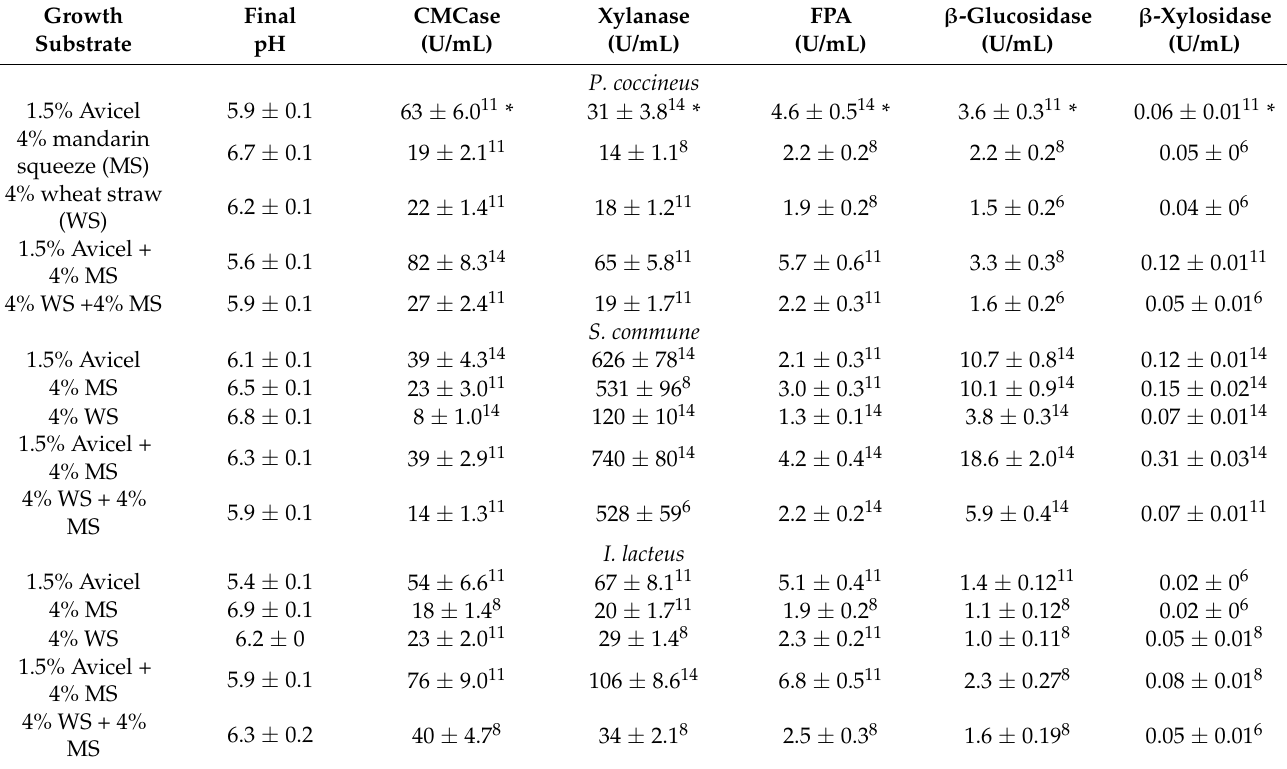
Table 1. Modulation of basidiomycetes hydrolytic enzyme activity by chemically different growth substrates.